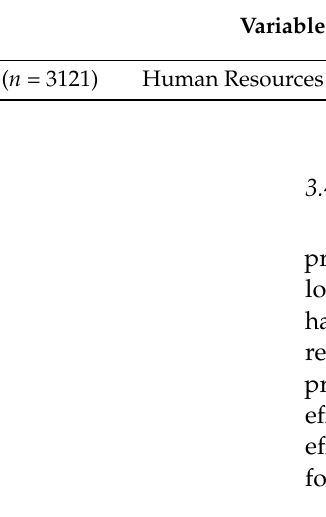
Table 4. Effect size for self-reported health-related production loss and HRI, RJI, and short-term recovery.